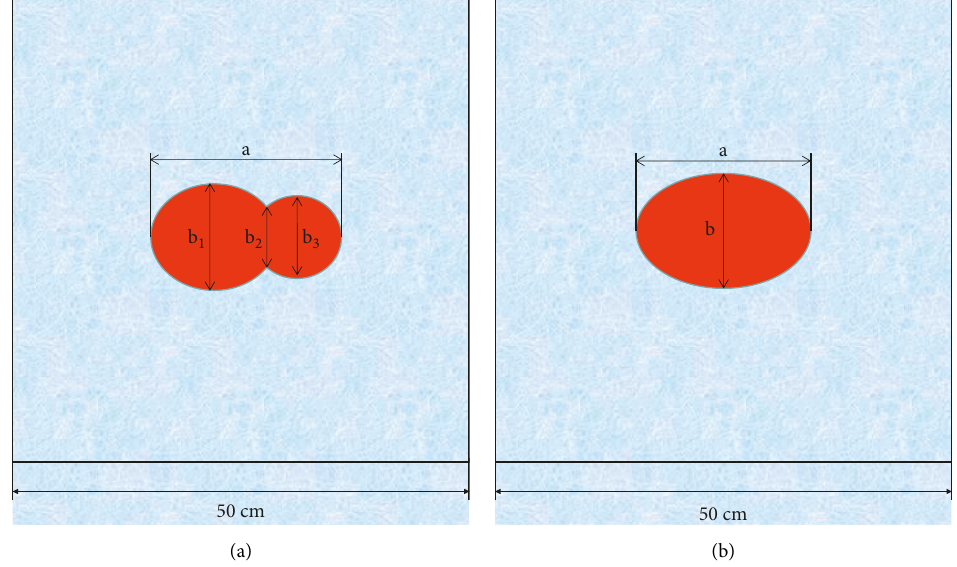
Figure 9: Schematic diagram of the shape of the deicing area. (a) Spindle-shaped deicing area. (b) Oval deicing